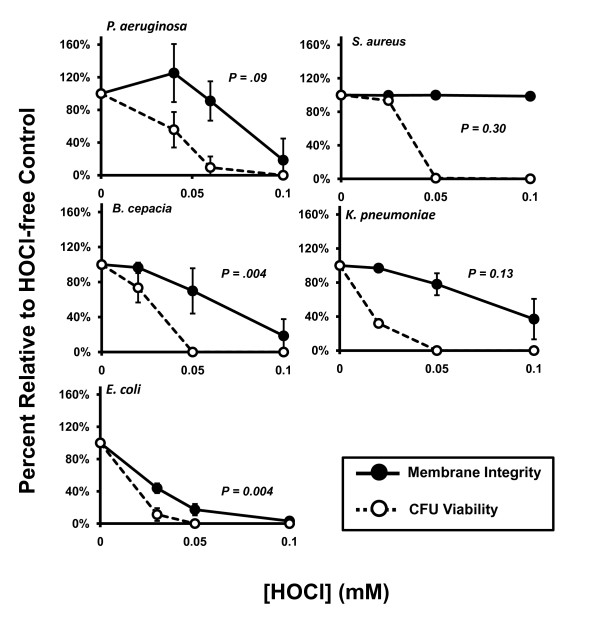
Correlating HOCl-induced membrane permeability and CFU viability. Bacteria were exposed to reagent HOCl in vitro to determine the effect of the oxidant on membrane integrity as measured by the BacLight Bacterial Viability and Counting Kit (Molecular Probes). Concentrations of HOCl used were based on the amounts necessary to eradicate CFU viability as assessed in the previous experiments. In general, bacterial membranes remain intact at concentrations beyond that required to inhibit CFU formation and kill the organism. Under these conditions, PsA, SA, and KP were killed at statistically lower concentrations of HOCl than were required to produce the same degree of membrane permeabilization. Membrane permeabilization by HOCl in BC and EC correlated with loss of CFU viability. Solid circles and lines: membrane integrity. Open circles and dotted lines: bacterial viability. Both parameters were expressed as percent relative to oxidant-free controls. P-values represent linear regression of the raw data values from membrane permeability versus CFU viability. Values less than 0.05 were considered significant and denote correlation among the parameters; values greater than 0.05 indicate independence of the parameters. Error bars represent standard deviation of at least n = 3 experiments.